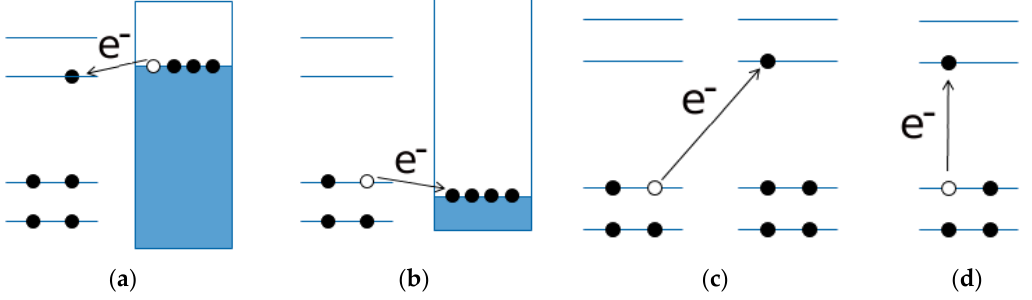
Figure 4. The white circles represent holes and the black circles electrons. In ( a , b ) the pseudo-fermi level of the polarized electrode is represented by the line on top of the dark rectangle representing the conduction band of the solid; ( c , d ) depicts the intermolecular and intramolecular electronic transitions, respectively. The other lines represent the orbitals in the polymer molecules while the arrows represent the electron transfer.